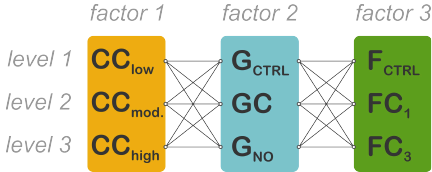
Fig. 4. Schematic of scenario coupling used in the ANOVA. The set of climate scenarios is reduced to three scenarios with a low, a moderate and a high temperature increase. The full range of glacier extents is assessed (from G CTRL to G NO , cf. Sect. 2.2) and the for- est change is represented by the control extent (F CTRL ) , the tree line increase only (FC 1 ) and the additional ingrowth and soil gene- sis (FC 3 , cf. Sect. 2.3).